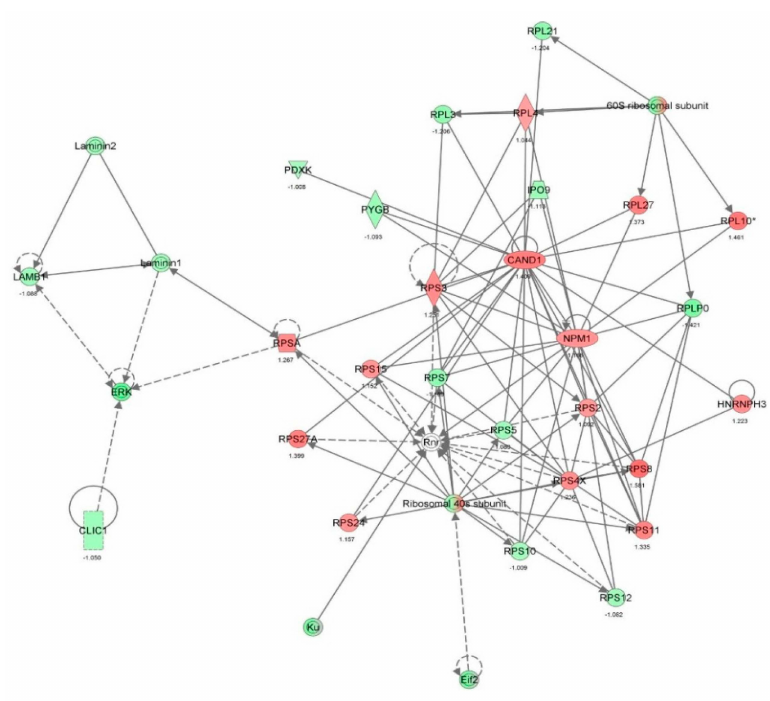
Figure 5. Vancomycin regulated hematological disease, organismal injury and abnormalities, and RNA post-transcriptional modification. Red indicates an up-regulation; green indicates a down-regulation. The intensity of green and red colors indicates the degree of down- or up-regulation. Solid arrow indicates direct interaction and dashed arrow indicates indirect